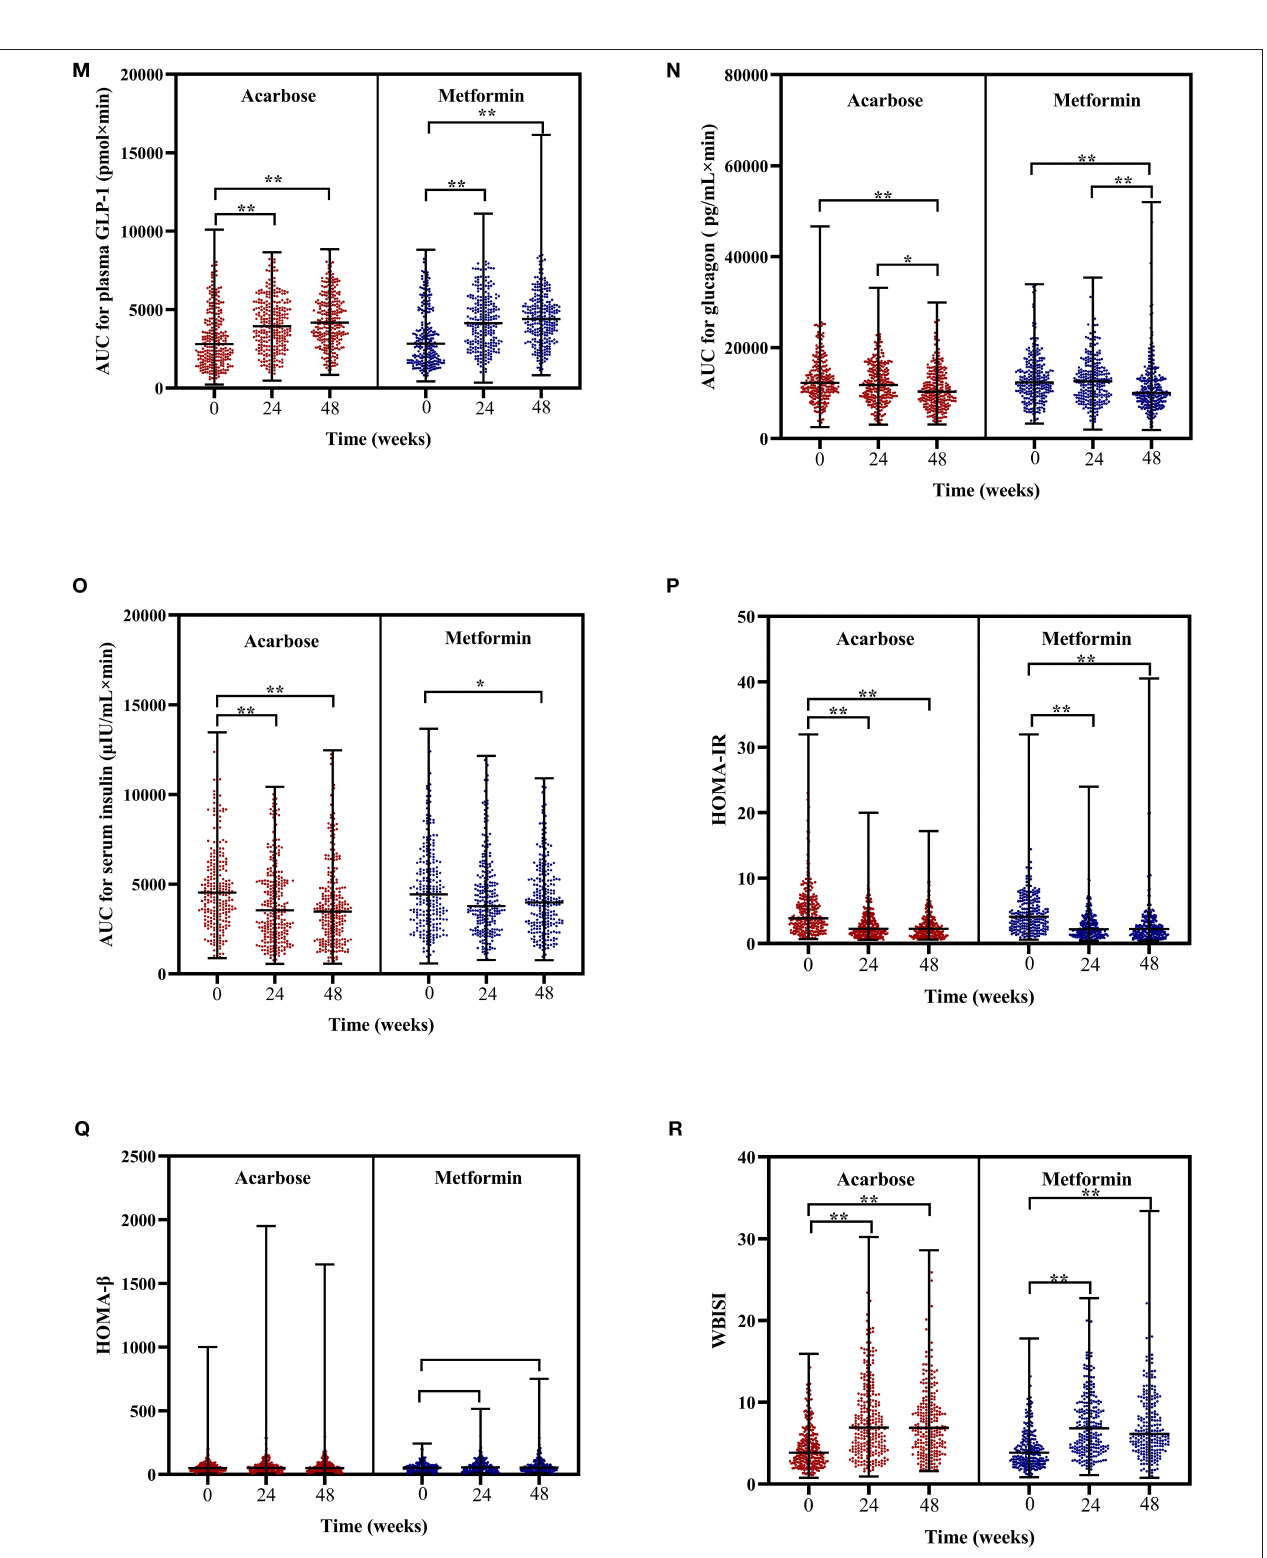
FIGURE 2 | Scatter plots of BMI (A) , SBP (B) , DBP (C) , TC (D) , TG (E) , HDL-C (F) , LDL-C (G) , FBG (H) , HbA1c (I) , 2hPPG (J) , FINS (K) , EISI (L) , AUC for plasma GLP-1 (M) , AUC for glucagon (N) , AUC for serum insulin (O) , HOMA-IR (P) , HOMA- β (Q) , and WBISI (R) in patients subjected to metformin or acarbose groups